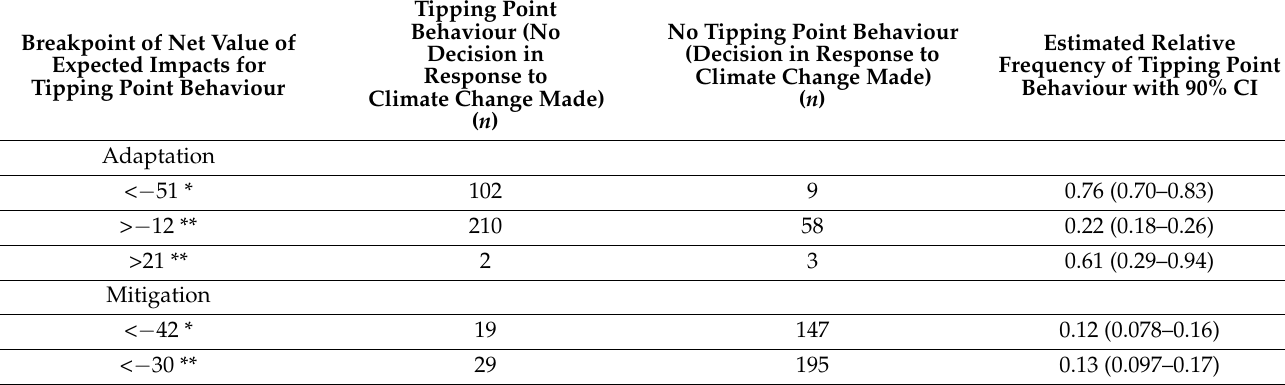
Breakpoint of Net Value of Expected Impacts for Tipping Point